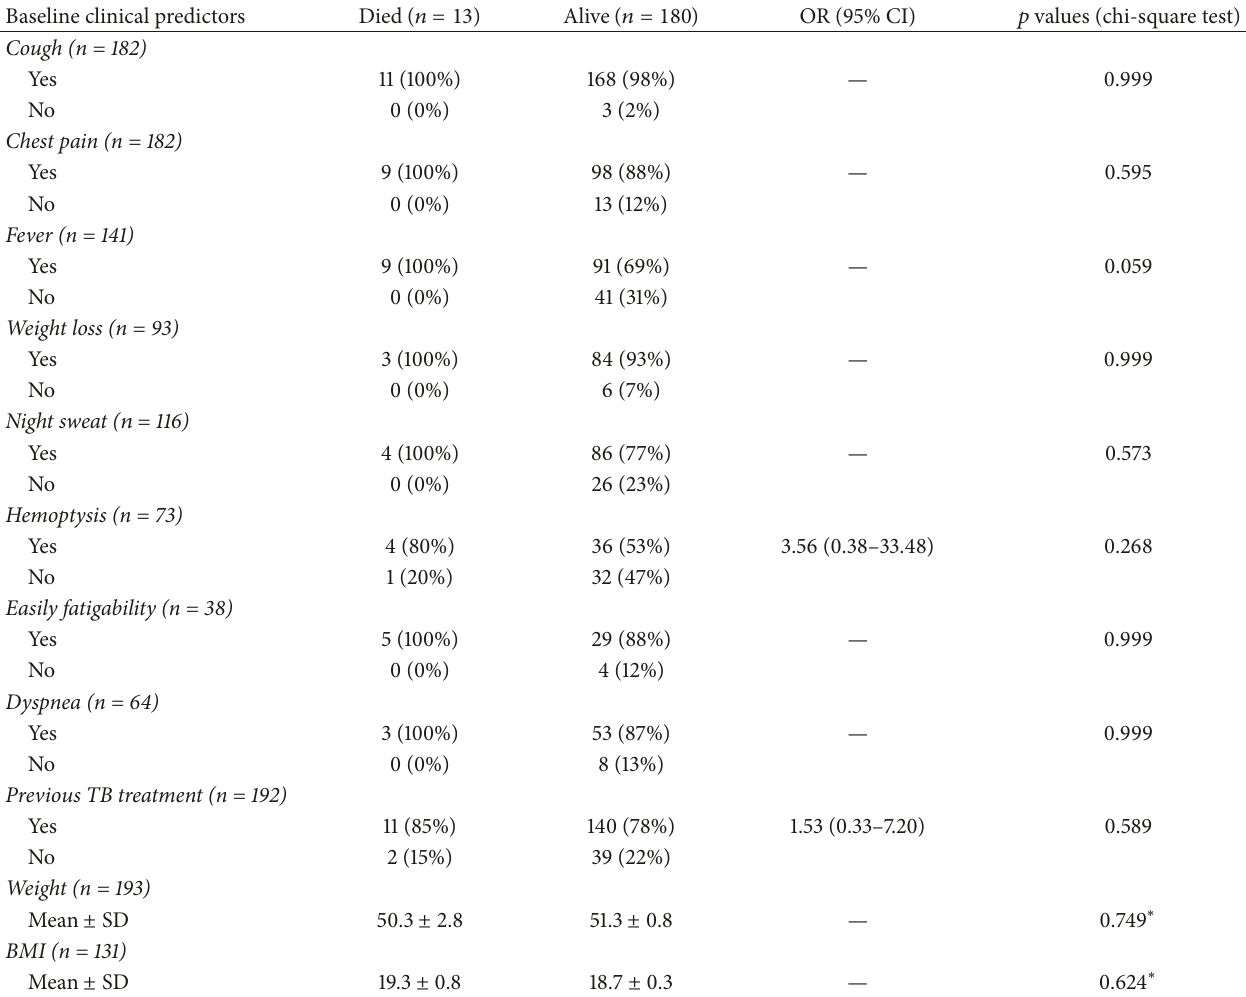
Table 3: Clinical predictors of MDRTB